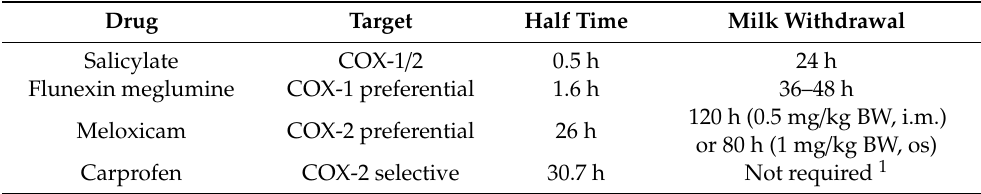
Table 1. Principal qualitative aspects of nonsteroidal anti-inflammatory drugs